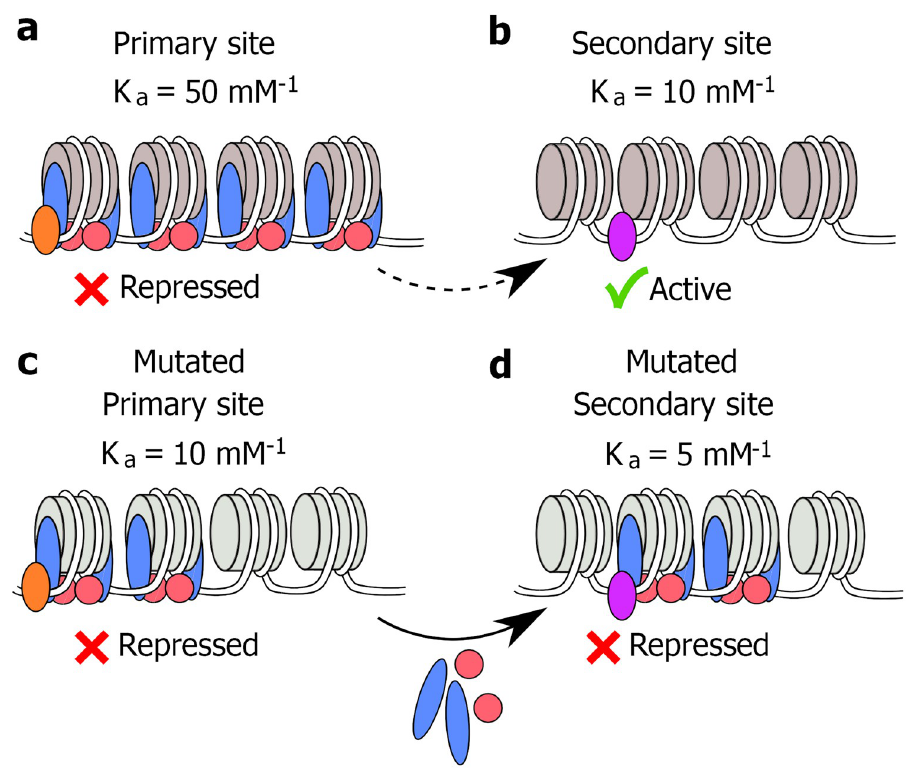
Fig 7. A model for the redistribution of Sir3 in the genome of some histone mutant strains. The Sir3/Sir4 complex is recruited to a high-affinity binding site by a DNA bound factor to form a heterochromatin domain that represses the covered gene ( a ). The affinity of Sir3/Sir4 for the secondary binding site is significantly less, and little or no Sir3/Sir4 complex binds to this site, allowing the associated gene to remain transcriptionally active ( b ). The mutation of a residue on the nucleosome face that interacts with Sir3 decreases the affinity for the primary binding site significantly ( c ). Although the affinity of the secondary binding sites also decreases, the presence of a different DNA bound factor at this site may modulate this decrease ( d ). The comparable affinities of the mutated primary and secondary binding sites allow Sir3/Sir4 to migrate from primary to secondary binding sites, causing repression of genes associated with the secondary binding sites ( d